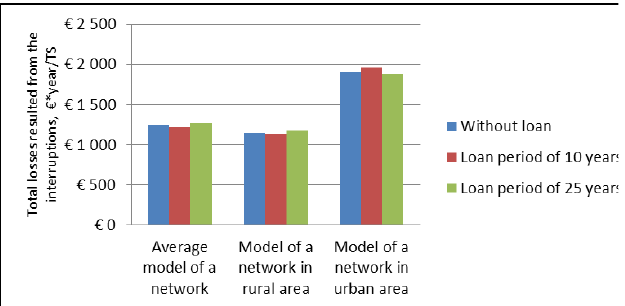
Fig. 9. Total losses resulted from the interruption for the case of breakers